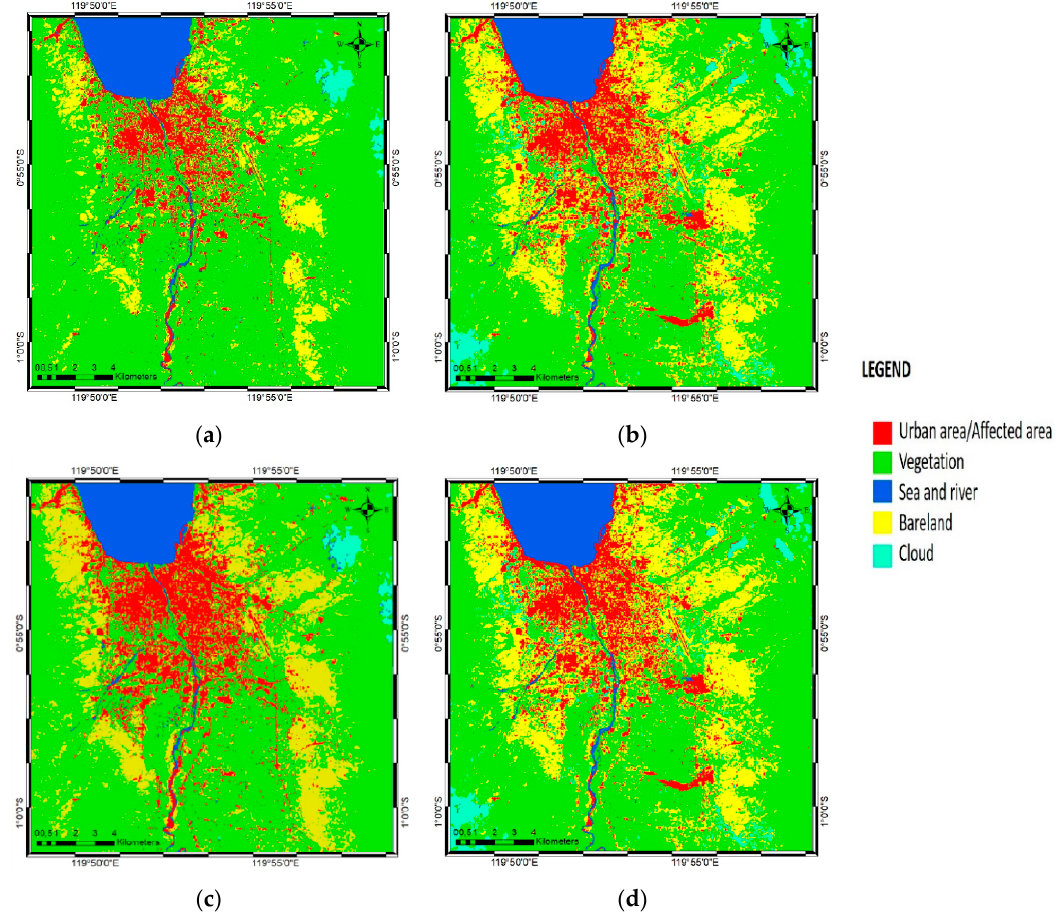
Figure 8. Results of the ANN and SVM classifications based on Landsat ‐ 8 imagery of Palu, Indonesia: ( a ) ANN pre ‐ earthquake map; ( b ) ANN post ‐ earthquake map; ( c ) SVM pre ‐ earthquake map; and ( d ) SVM post ‐ earthquake map.